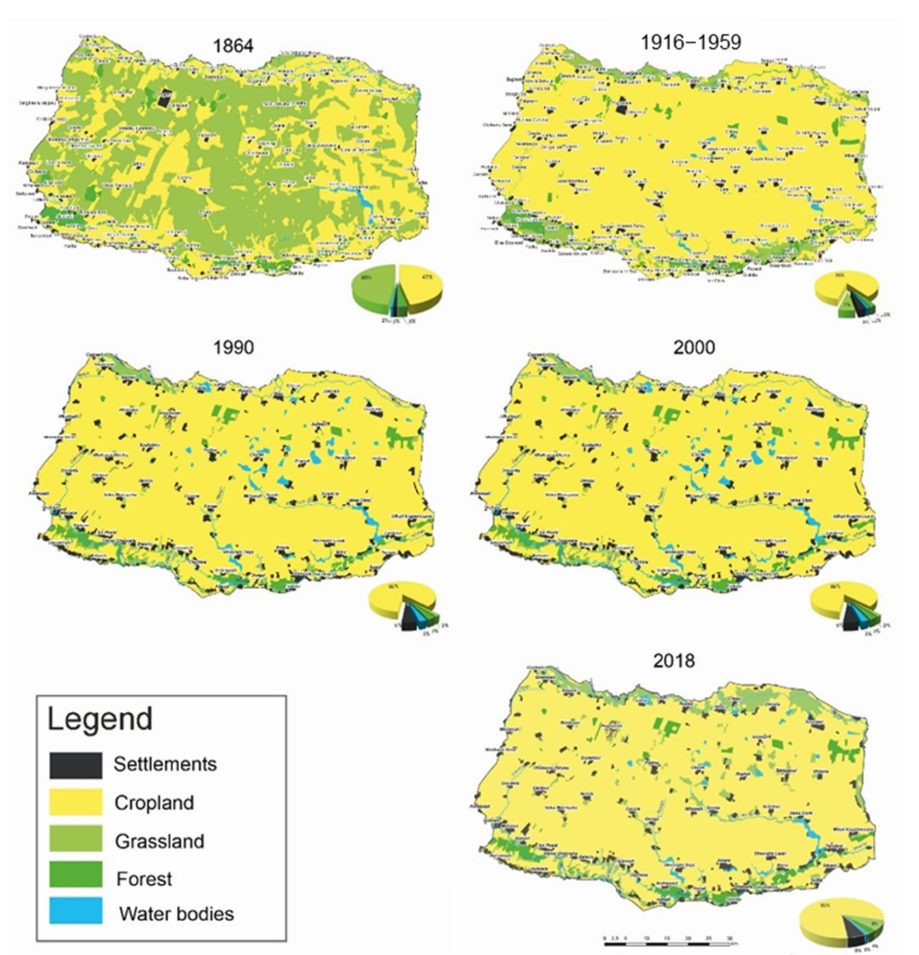
Figure 3. Distribution of land resources in Central B ă r ă gan, in 1864, between 1916–1959, 1990, 2000 and